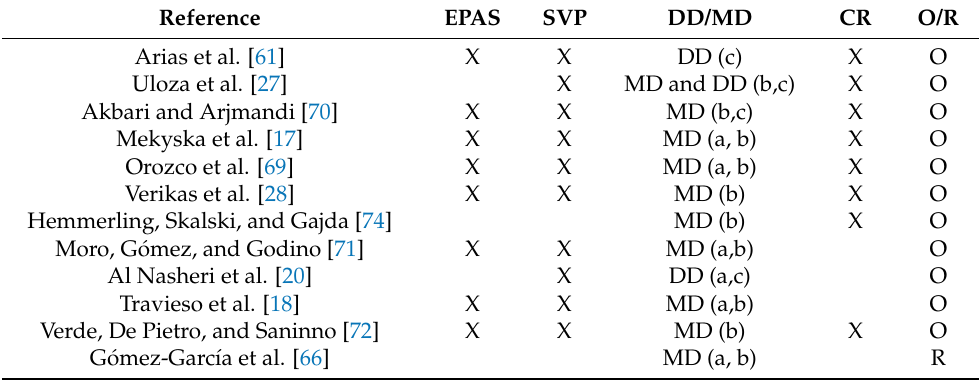
Table 2. Pathological speech and voice evaluation approaches reviewed in the present study (Selected accordingly to the criteria before mentioned: addressing laryngeal pathology characterization from acoustical signal analysis, having been published since 2010, disclosing classification or regression methodology, based on standard databases or supplementary materials to allow reproducibility, supported by reliable performance metrics, and contributing novel and original work.). EPAS: Exploratory or prospective advanced statistics; SVP: Statistical validation of performance; DD/MD: Data-driven or model-driven (the label within parenthesis indicates the strategy of the approach regarding Figure 3, as a, b, c, d, or a combination); CR: Clinical relevance; O/R: Original contribution or